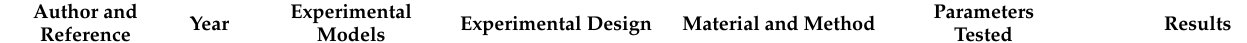
Table 3. Summary of findings from the experimental animal